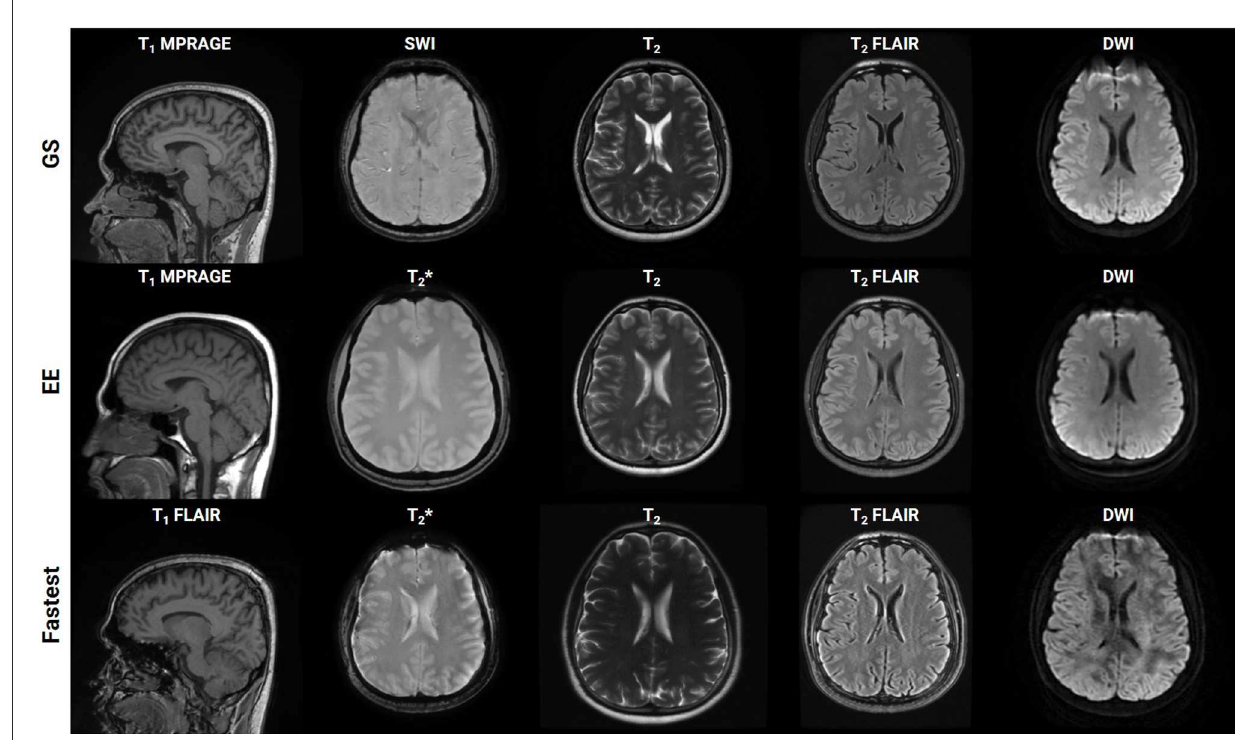
FIGURE4 Collage of one representative slice of an arbitrarily chosen subject, across contrasts (columns), across the Gold Standard (GS), and Fastest and Expert Express (EE) protocols (rows). The subpanels have been individually